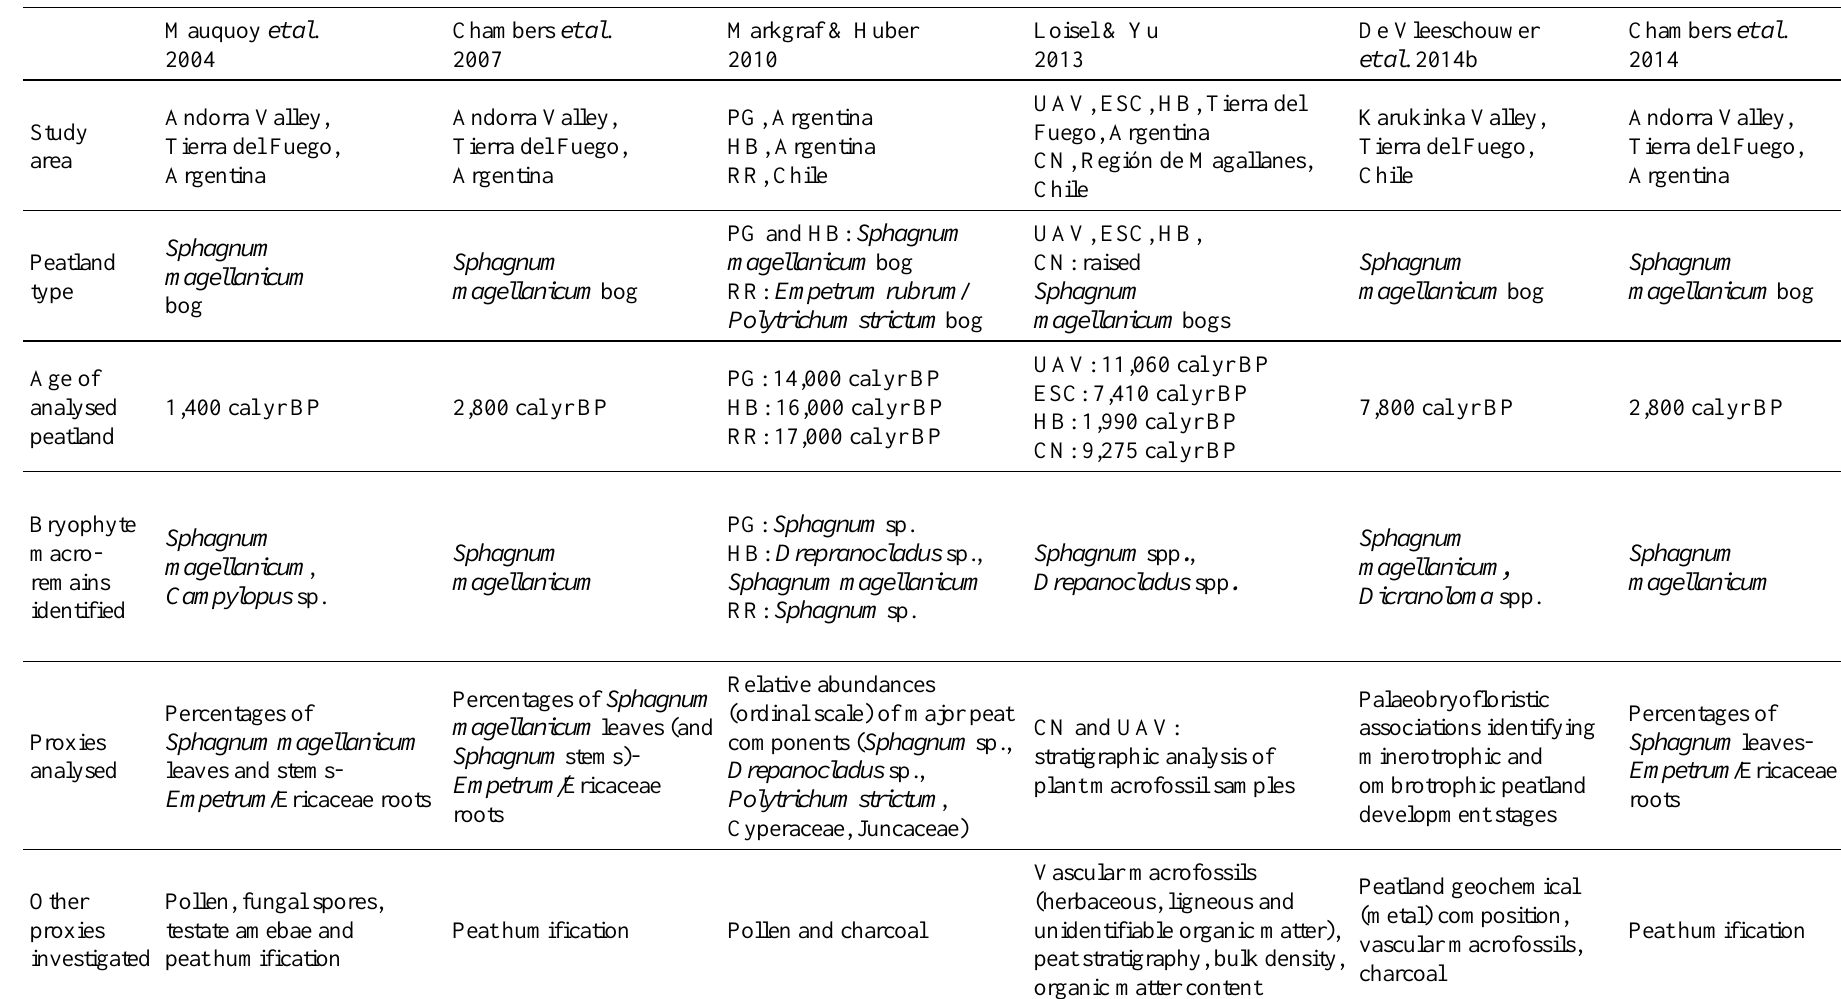
Table A2. Studies of southern South American peatlands where bryophyte macrofossils were used to make palaeoenvironmental reconstructions. ESC: Escondido; CN: Cerro Negro; HB: Harberton, Tierra del Fuego, Argentina; PG: Paso Garibaldi, Tierra del Fuego, Argentina; RR: Río Rubens, Región de Magallanes, Chile; UAV: Upper Andorra